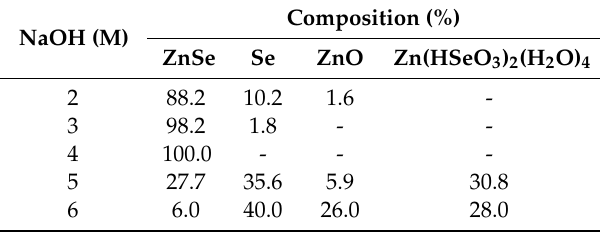
Table 1. Phases of the synthesized ZnSe / GO composite by varying the NaOH